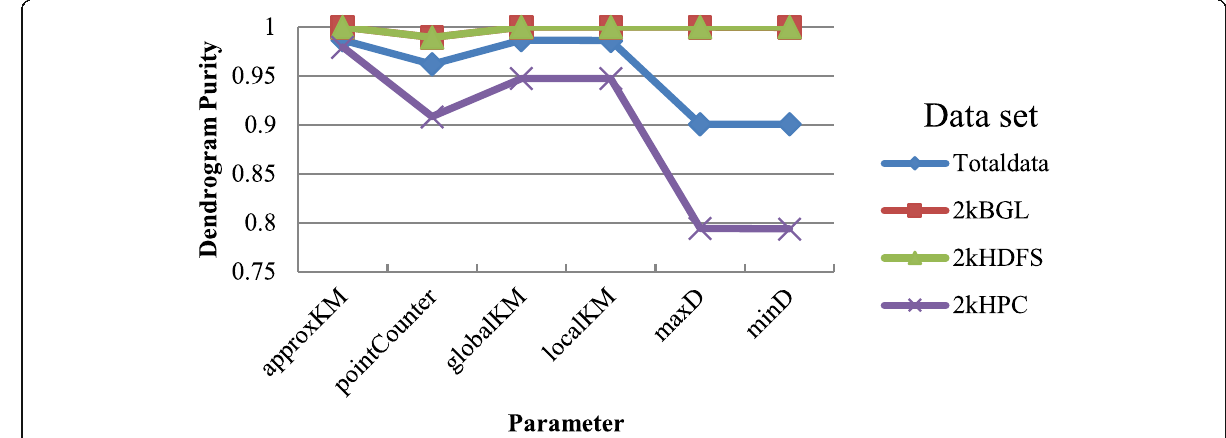
Fig. 11 Dendrogram purity of clustering tree corresponding to different parameters clustering on different data